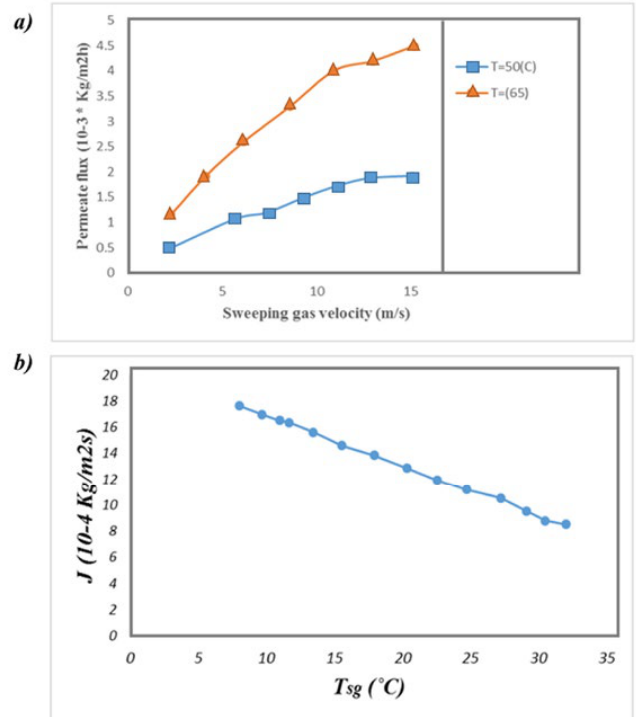
Fig. 7: a) Effect of the sweeping gas velocity in the distillate channel under two constant feed temperatures (feed velocity of ʋ = 0.10 m/s) on the distillate flux, b) Effect of the temperature of sweeping gas on the distillate flux (J).